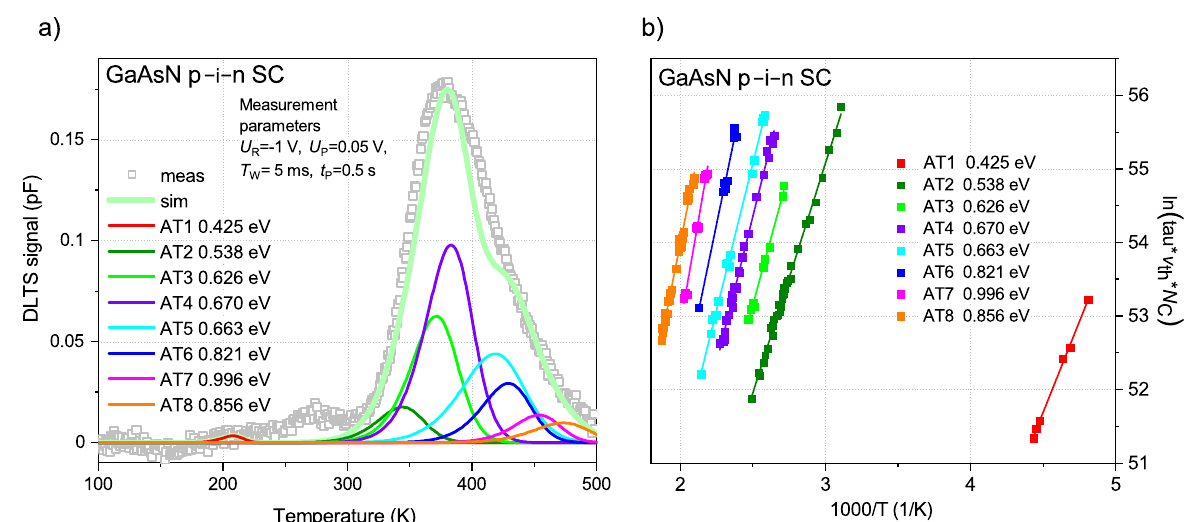
Figure 10. DLTFS results of GaAsN solar cell structure: ( a ) typical measured capacitance spectrum of GaAsN, measured parameters, calculated values of activation energies, cross-captures and simulated curves for identified deep energy levels ( b ) corresponding Arrhenius plot. Table 3. Parameters of the identified deep energy levels in investigated GaAsN p-i-n solar cell. Trap Number Trap Energy E C − E T (eV) Cross Section σ T (cm 2 ) Probable Origin Reference AT1 AT2 AT3 AT4 AT6 AT7